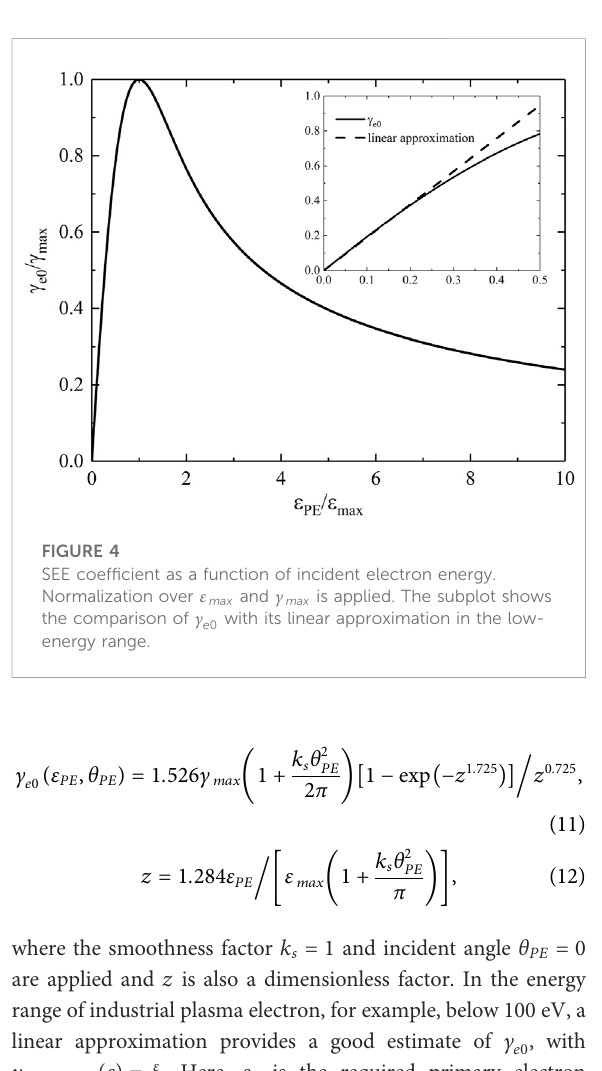
energy that produces one secondary electron. The values of ε 1 (cid:1) 1 in Eq 11. A comparison of are determined by setting γ e 0 linear approximation and real γ is shown in the subplot of e 0 Figure 4. A range of such empirical formulae exists which gives similar pro fi les of γ [19, 32]. e 0